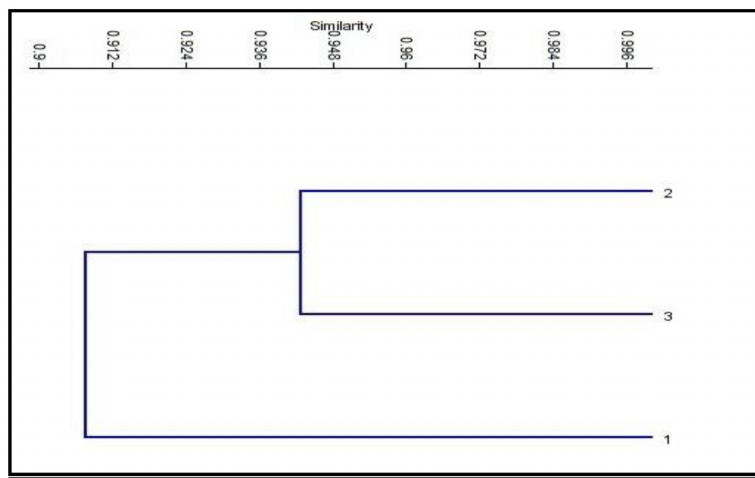
Figure 4. Neighbor-joining phylogenetic tree constructed from SRAP data following the analysis of control and two treatments of Solidago canadensis cv. Tara plant. 1: Control (without any treatment); 2: BRs at 10 − 8 M; 3: CHT 200 mg /